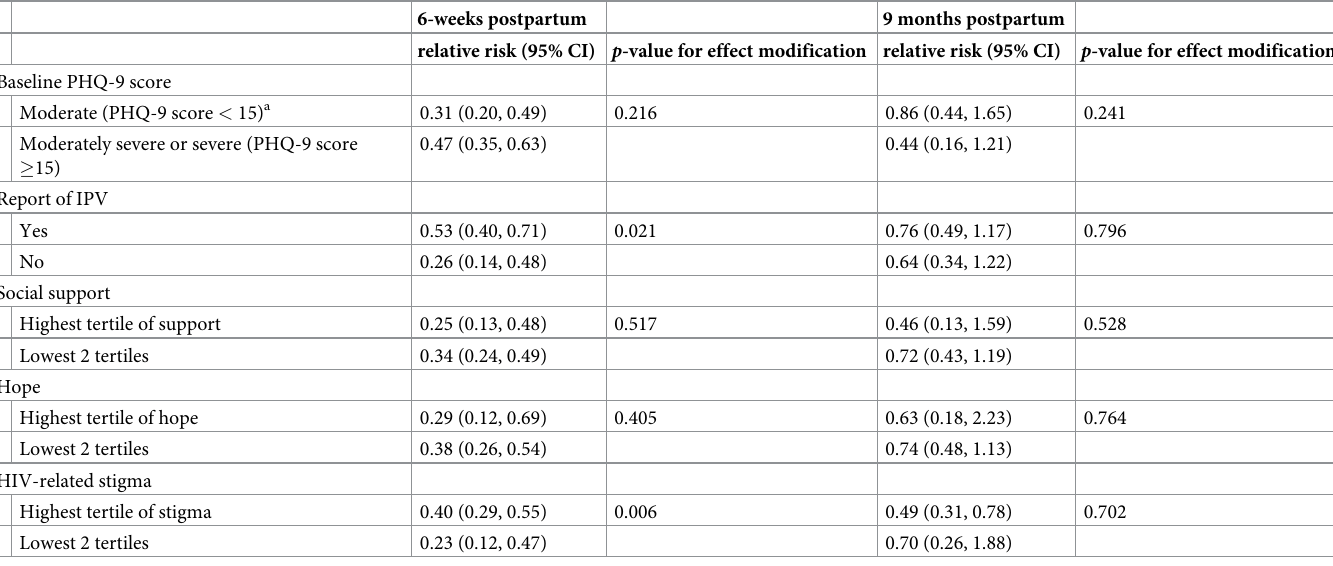
Table 4. Exploratory analysis of the effect of the intervention on symptoms of depression comparable to MDD at 6 weeks and 9 months postpartum stratified by effect